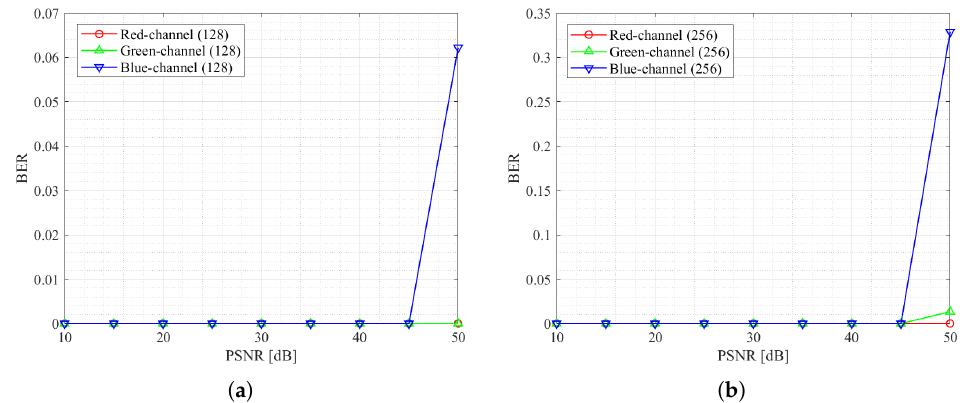
Figure 12. Comparison of BER according to PSNR. ( a ) 128 × 128 pixel size. ( b ) 256 × 256 pixel